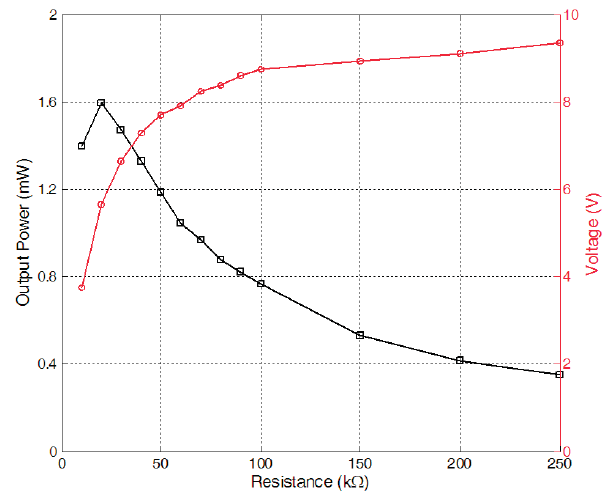
Figure 4. Output power versus resistance with wind speed of 11.2